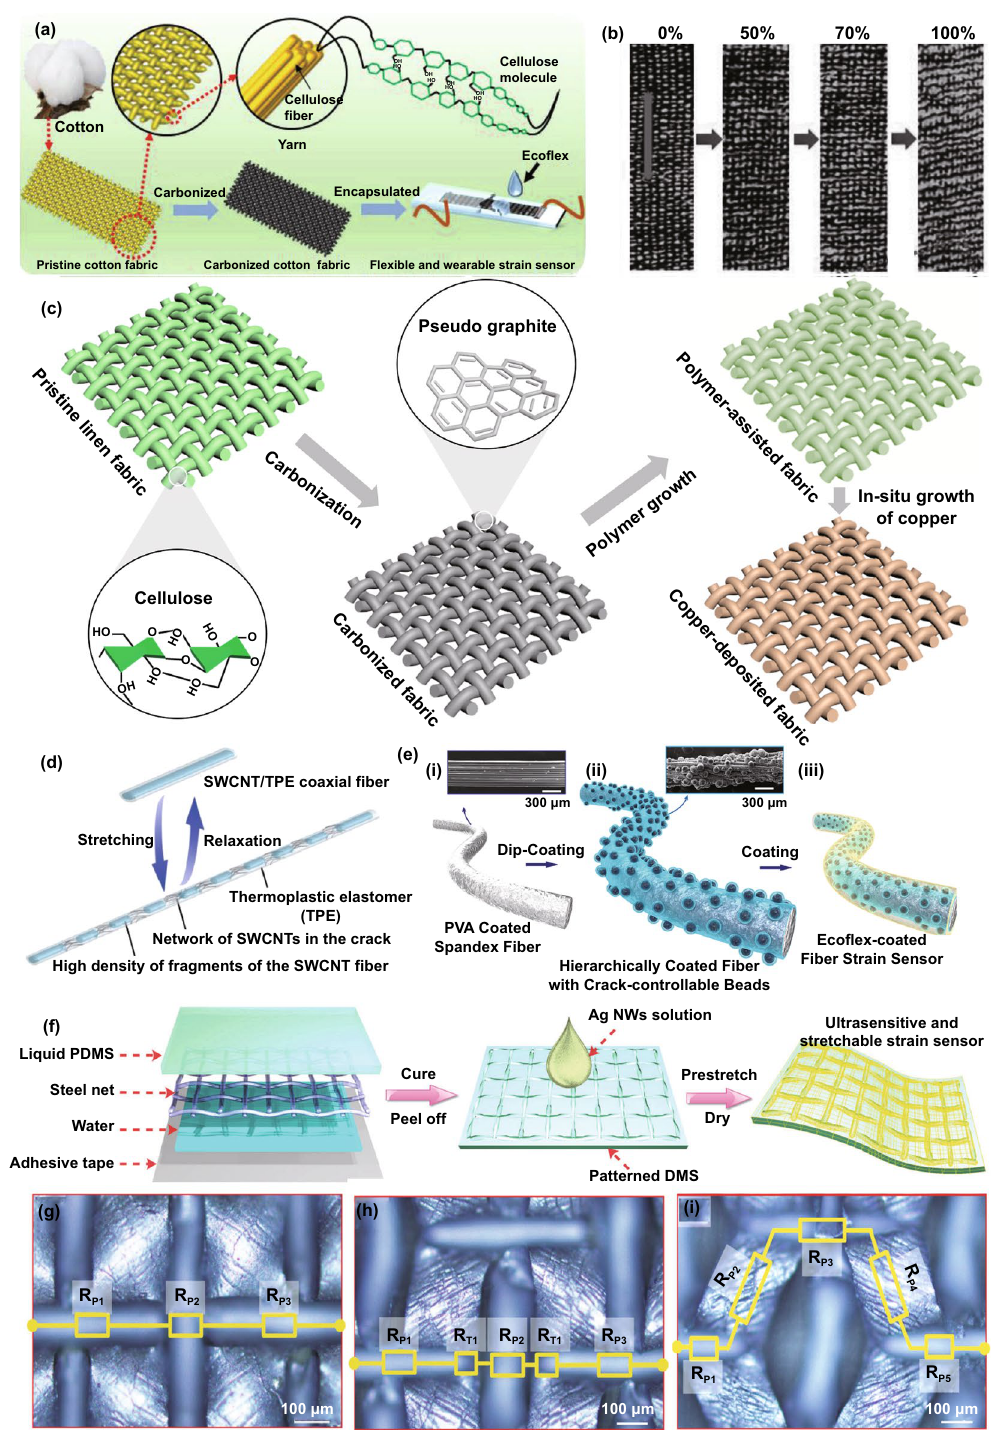
Fig. 4 a Carbonized cotton fabric with Ecoflex encapsulation for strain sensing, and b images of the sensor with diverse applied strain [141]. Copyright © 2017 Wiley–VCH. c Fabrication illustration of a strain sensor made with carbonized fabric with PAMD [153]. Copyright © 2021 Elsevier. d Illustration of sensing mech- anism of yarn-like strain sensors made with thermoplastic elastomer supported CNT [96]. Copyright © 2018 Wiley–VCH. e Fabrication illustration of hierarchical strain sensor with spandex fiber substrate, coating of beaded carbon nanomaterials, and Ecoflex encapsulated layer [145]. Copyright © 2019 American Chemical Society. f Fabrication illustration of the strain sensor with Ag NWs coating on patterned PDMS, g–i schematics of the strain sensor with increasing strain, and cor- responding analog circuits [158]. Copyright © 2017 Royal Society of